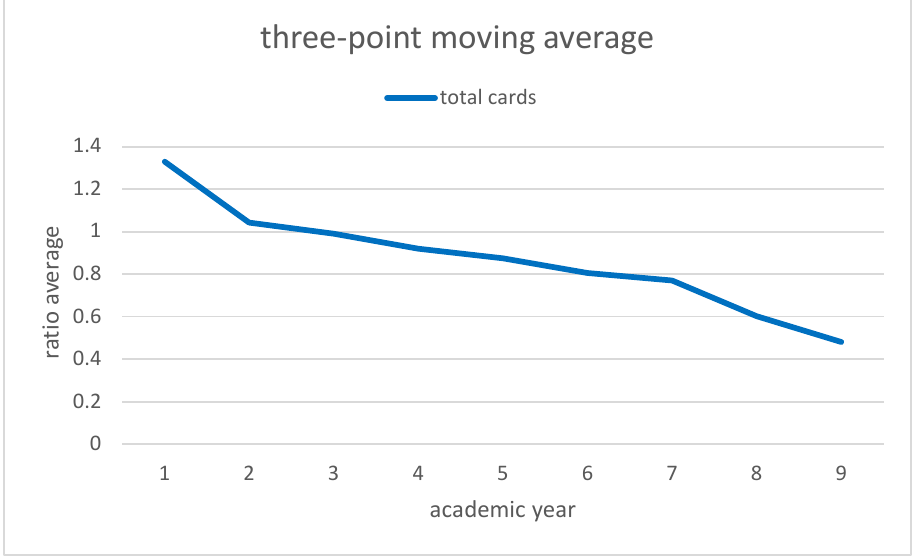
Figure 5. Three point moving average for total cards. Source: Own elaboration.